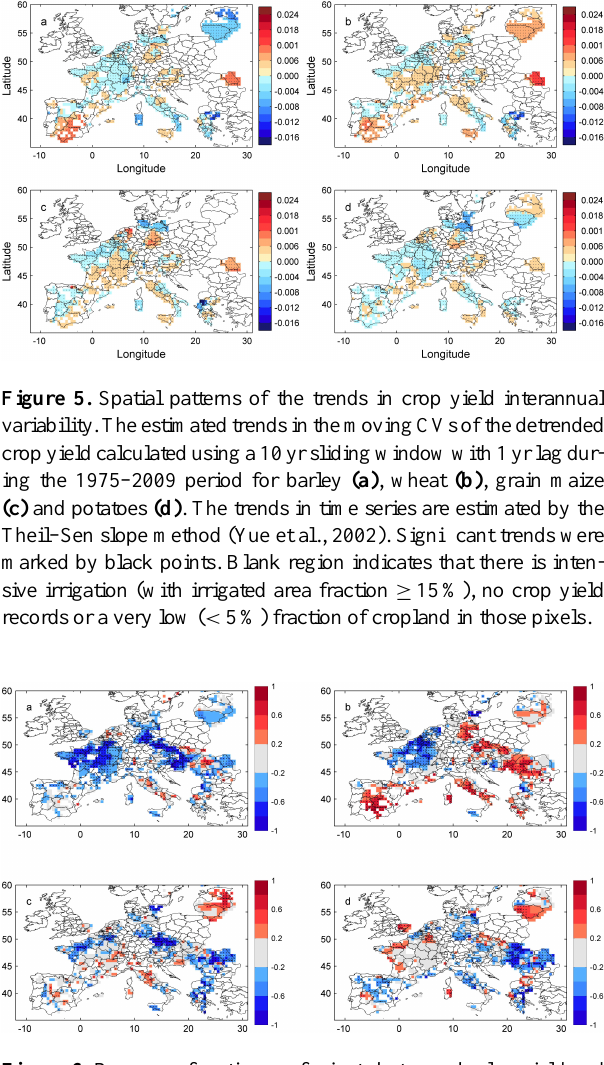
Figure 6. Response function coefficients between barley yield and mean growing-season temperature (a) , total growing-season wa- ter availability index (b) and consecutive frost days (c) and mean growing-season maximum of daily maximum mean temperature (d) . Significant response function coefficients between barley yield and climate are marked by black points. Blank regions indicate that there is intensive irrigation (with irrigated area fraction ≥ 15%), no crop yield records or a very low ( < 5%) fraction of croplands in those pixels.